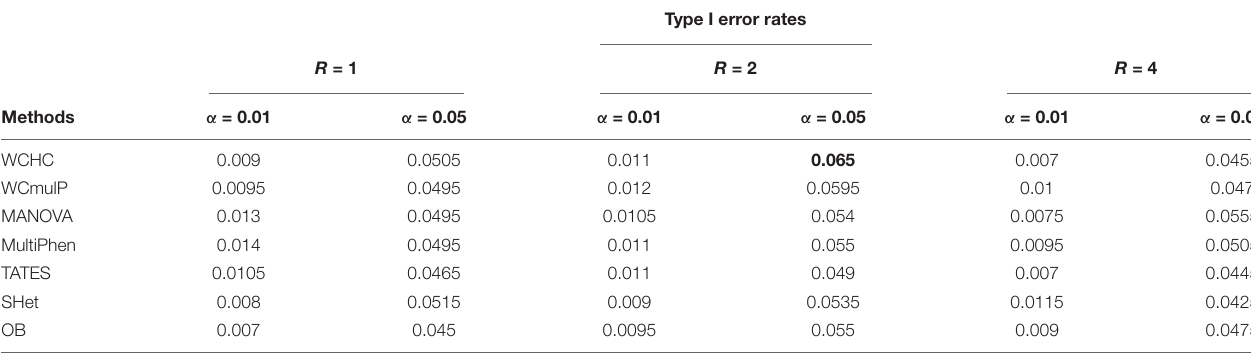
TABLE 1 | Type I error rates of the seven methods in three simulation settings.